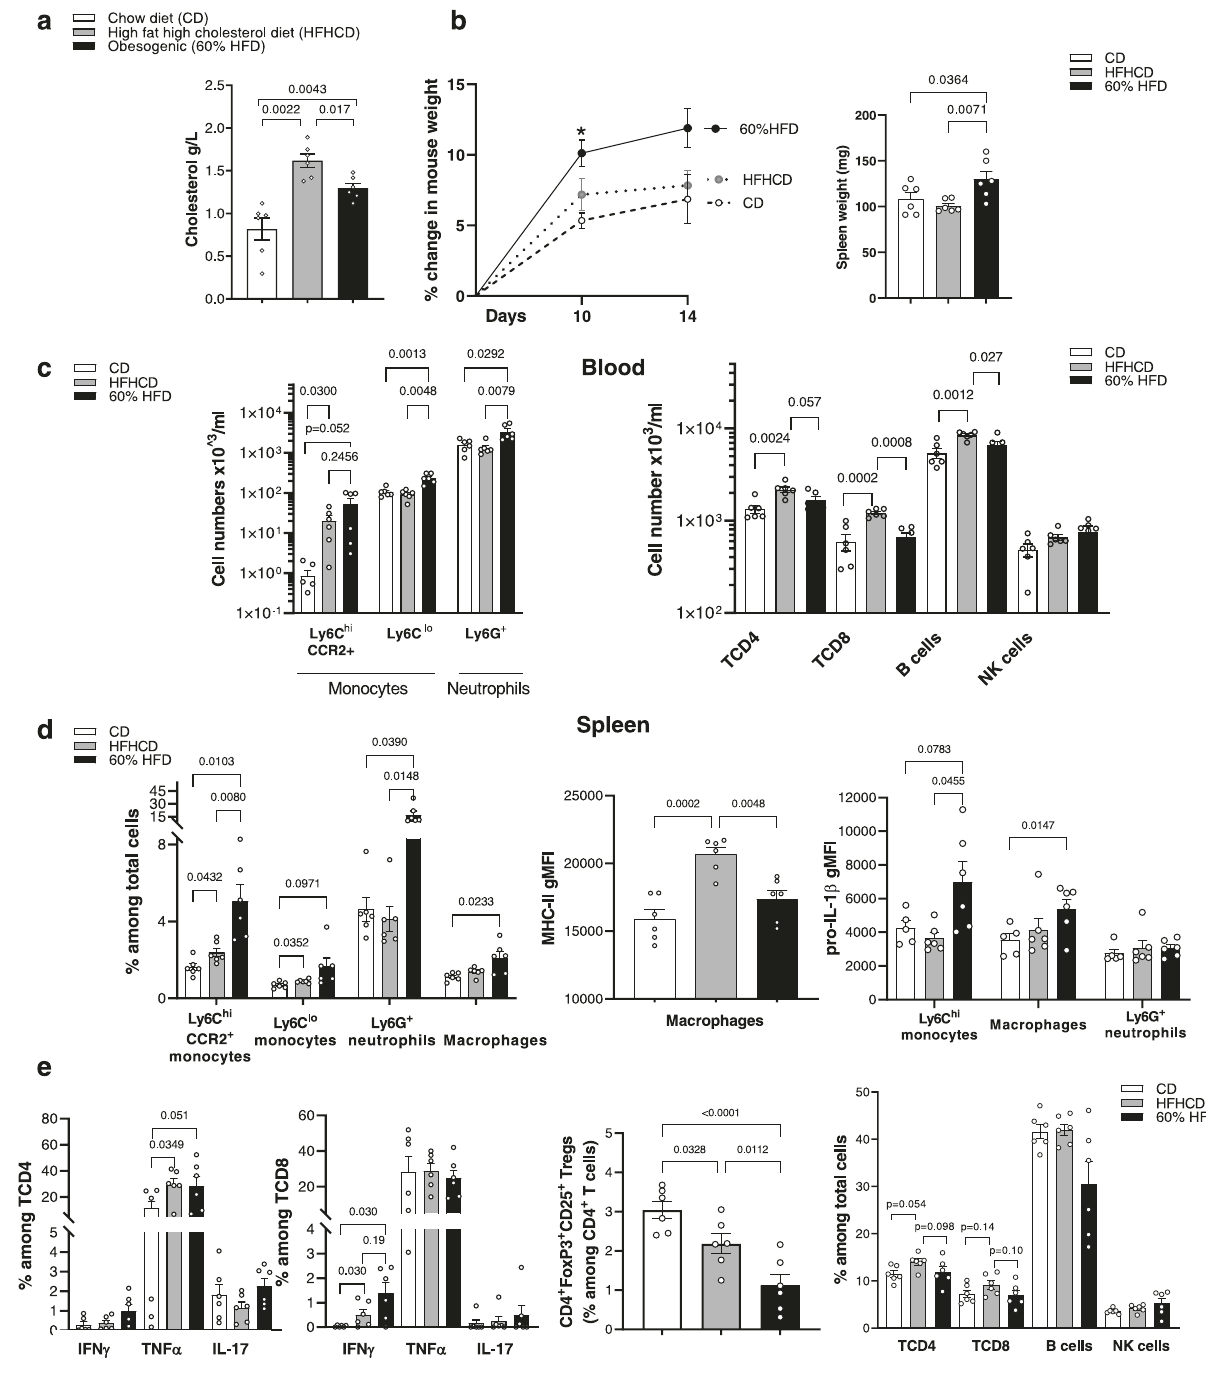
Fig.1|AtherogenicHFHCDinducesaspeci fi clow-gradein fl ammation. C57BL/6J mice were fed for 2 weeks with chow diet (CD), high fat high cholesterol diet (HFHCD) or obesogenic diet (60% HFD). a Plasmatic cholesterol measured by colorimetric assay. b Mouse weight variation (left) and spleen weight (right). c – e Flow cytometry analysis c in blood d , e in spleen. Splenocytes were incubated